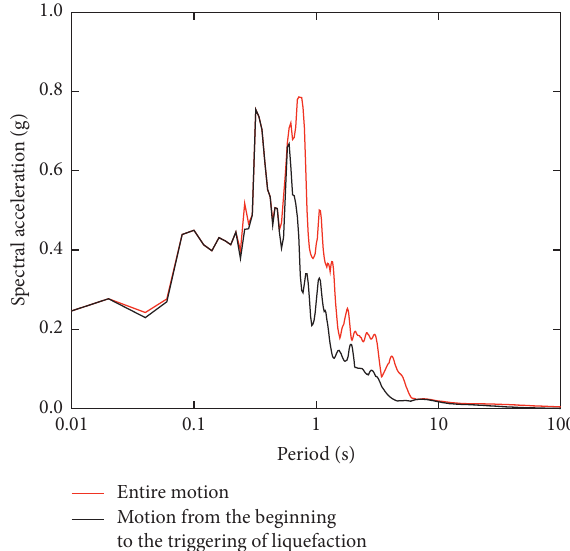
Figure 11: Ground surface response spectra by two-dimensional